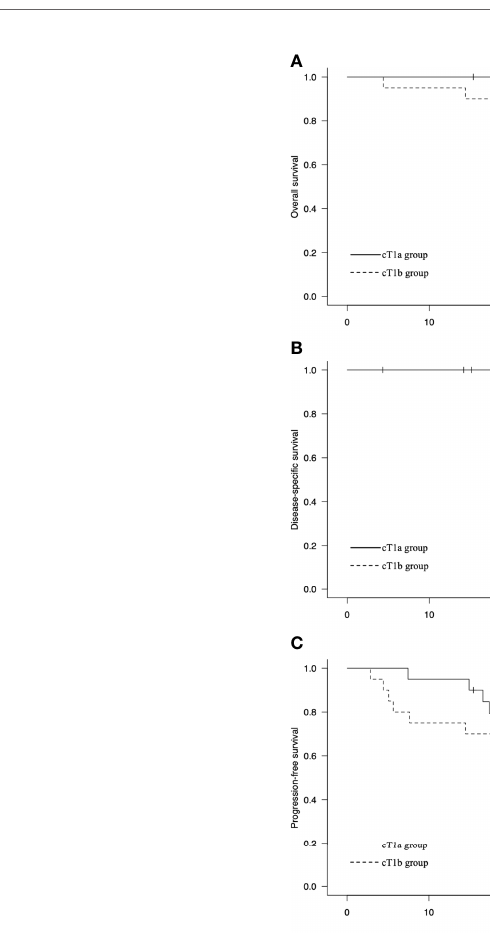
EC, respectively (24). In the cT1b group, the lower rate of regional recurrence after RT compared with that of regional metastasis at the time of surgery suggested that potential lymph node metastasis was suppressed by ENI and concurrent chemotherapy.